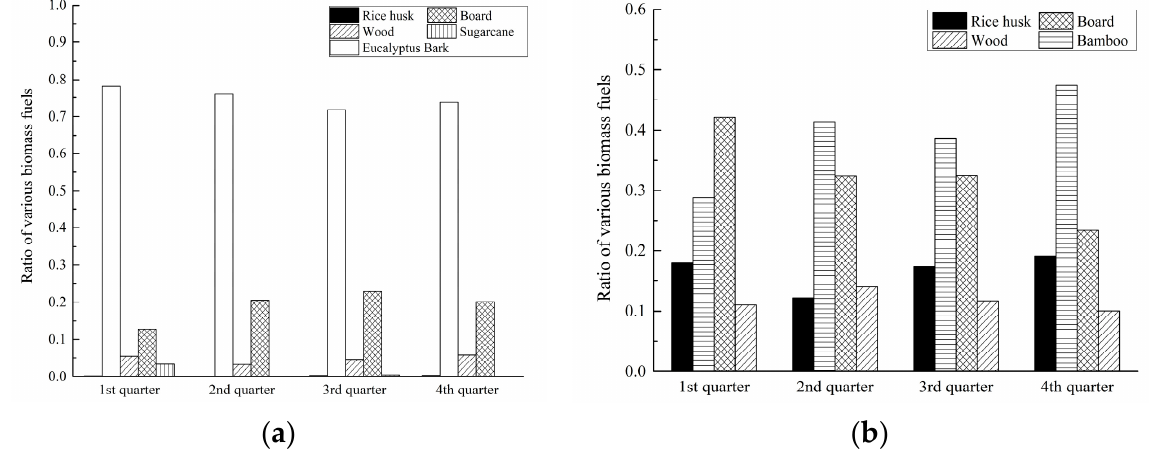
Figure 7. Fuel structure of biomass direct-fired power stations in ( a ) Guigang, Guangxi and ( b ) Hengyang, Hunan (in quarters, 2018).